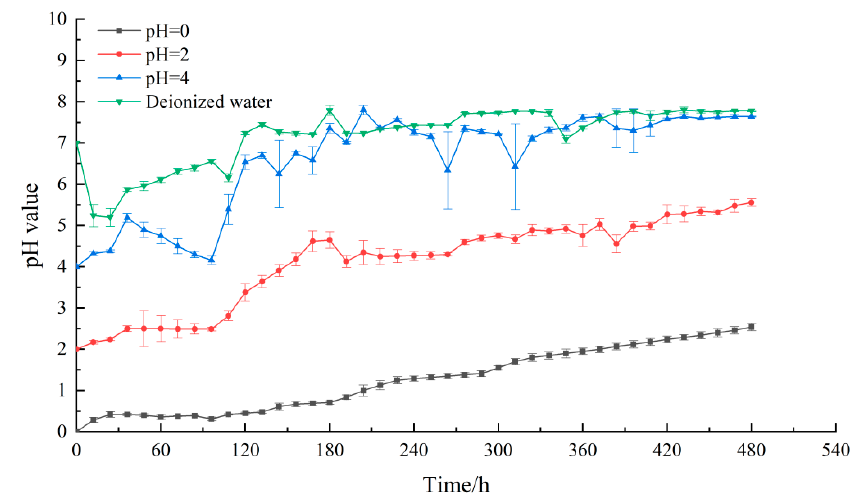
Figure 7. pH changes of the different solutions in tests.